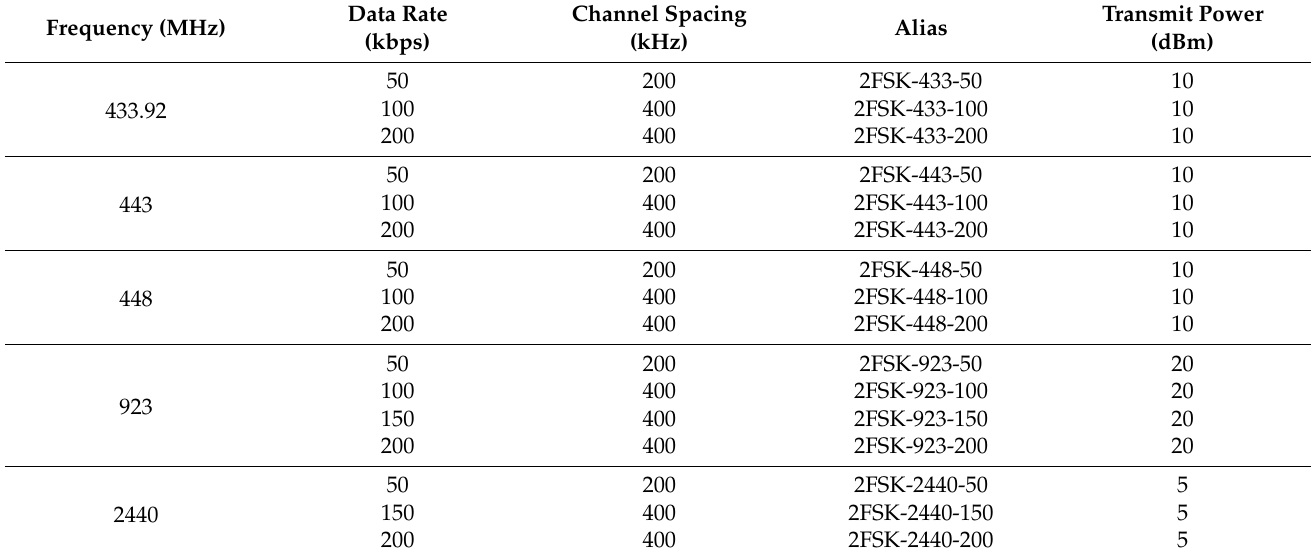
Table 1. The studied data rates and frequency bands of 2FSK PHY layer in